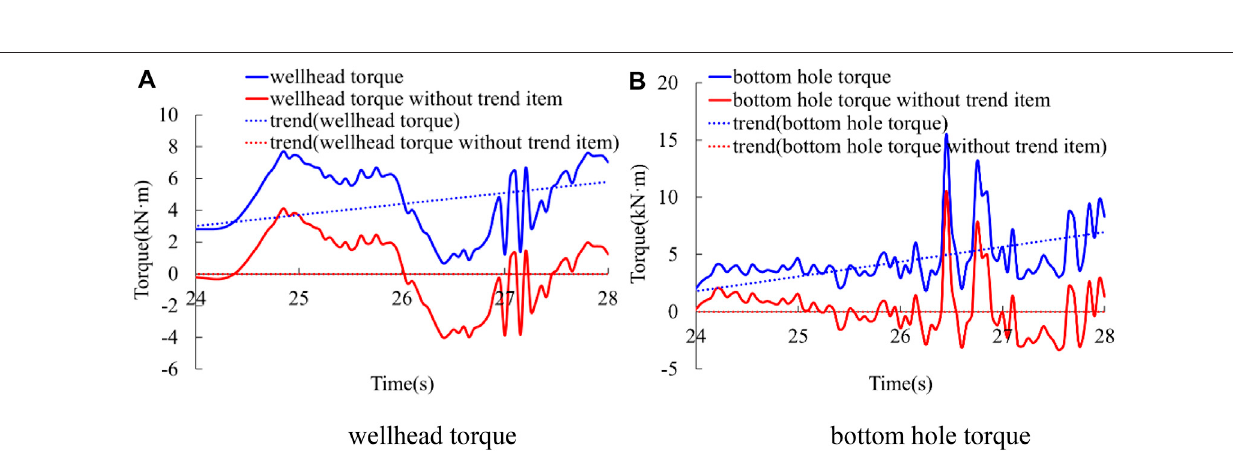
Frontiers in Earth Science |